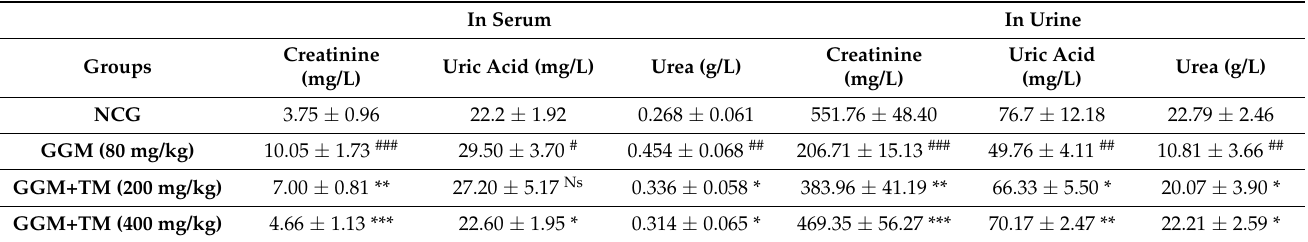
Table 3. Toxicity biomarkers in the kidneys of control and experimental rats. In Serum In